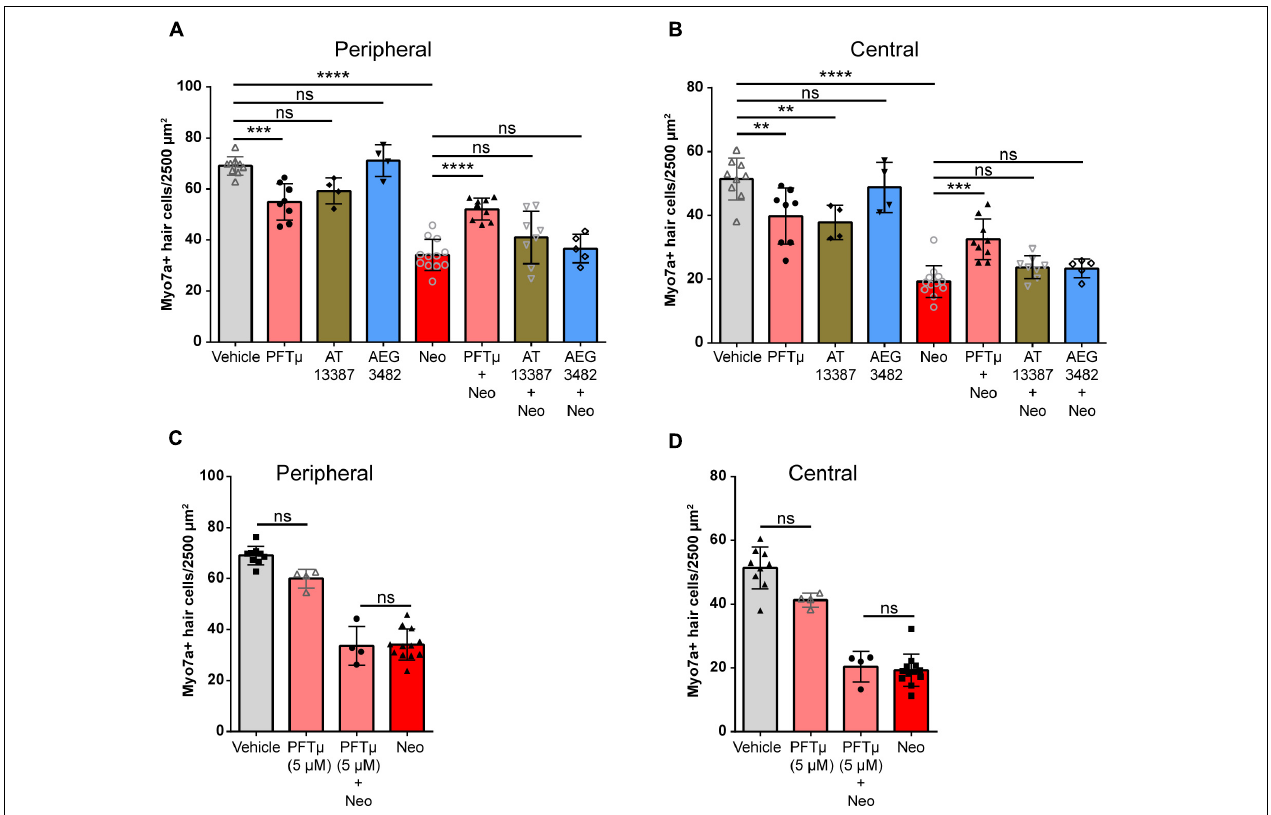
FIGURE 7 | Perturbagen hit pifithrin- µ reduces aminoglycoside-induced hair cell death in cultured mouse utricles. (A) Myosin VIIa- and Hoechst 33342-labeled hair cell counts in the peripheral region of utricles treated with vehicle (0.1% DMSO, gray), pifithrin- µ (10 µ M, pink), AT13387 (10 µ M, brown), or AEG3482 (25 µ M, blue). (B) Hair cell counts labeled as in (A) for the central region of the utricle. Hair cell count results in (A–D) are pooled from two independent experiments with the significant effects replicated in the second experiment ( n = 4–12 utricles per group). (C,D) Reducing the concentration of pifithrin- µ to 5 µ M reduces the toxicity of the compound but also abolishes the protection against neomycin-induced hair cell death in both the peripheral (C) and central (D) regions of the utricle. Asterisks represent adjusted p -values from Tukey post hoc test results following one-way ANOVA with ∗∗∗ representing p < 0.001, ∗∗∗∗ representing p < 0.0001, and ‘ns’ (not significant) representing p > 0.05. All error bars in (A–D) represent ± SD